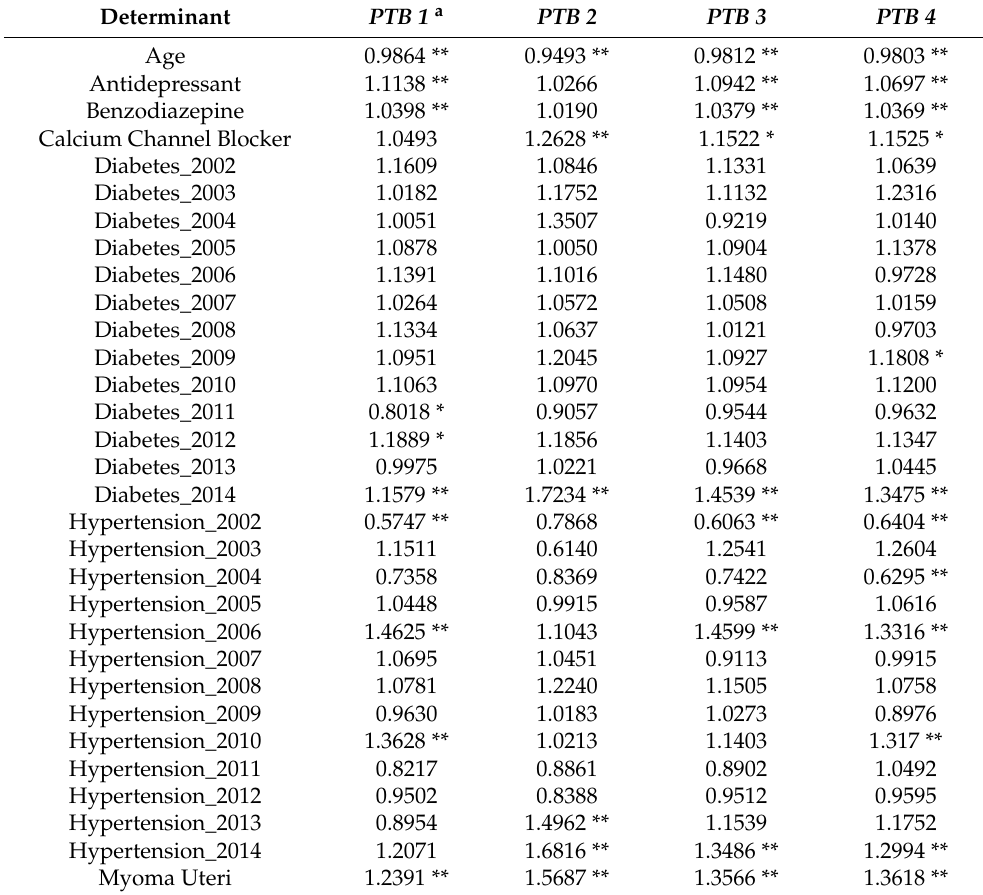
Table 4. Logistic Regression Results for Each Type of Preterm Birth: Non-Inflammatory Bowel Disease